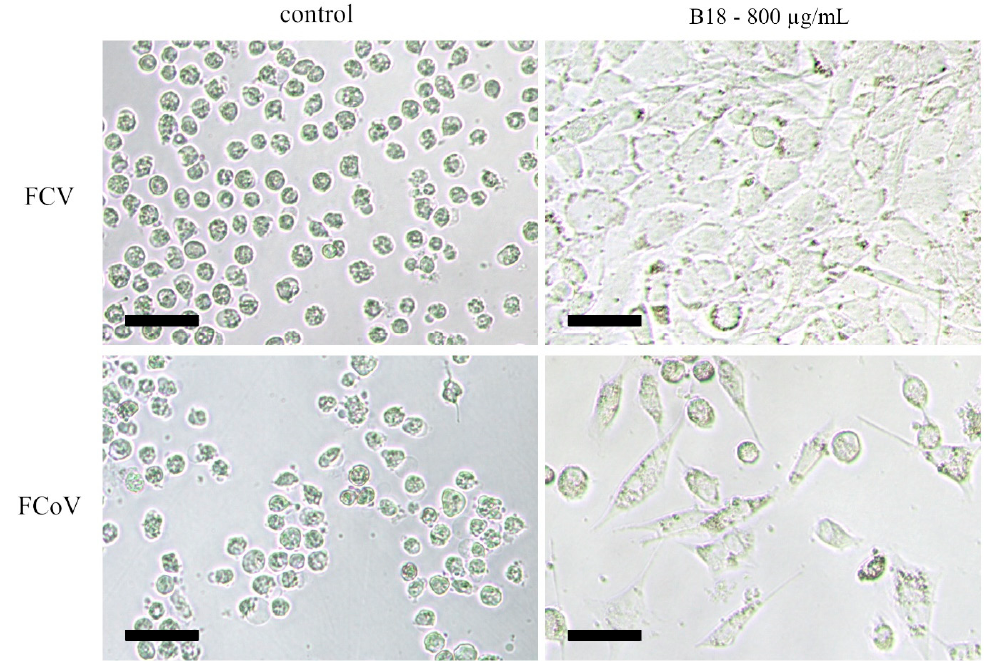
Figure 5. CRFK cells infected with FCV (top left) and FCoV (bottom left) in the control (solvent only) wells. The addition of the B18 extract inhibited the replication of both viruses (right) with a stronger effect on FCV. Note the healthy and infected cells after FCoV infection (bottom right) and the healthy monolayer after FCV infection (top right). Scale bar: 50 µm.